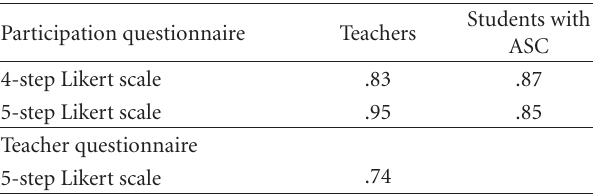
Table 2: Cronbach’s alpha values of intrarater reliability in the two questionnaires, across teachers and students and across 4- and 5- step Likert